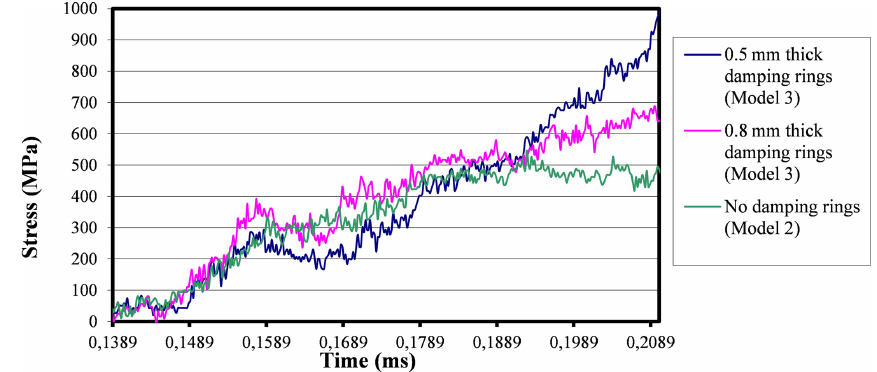
Figure 34. Stress-time curves pertinent to the actual experiment at 3.5bar when using 0.8mm thick, 0.5mm thick, and no damping rings.